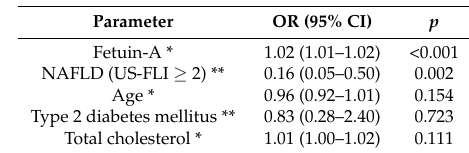
Table 2. Multivariate analysis exploring factors associated with coronary artery disease (vs. peripheral arterial disease).